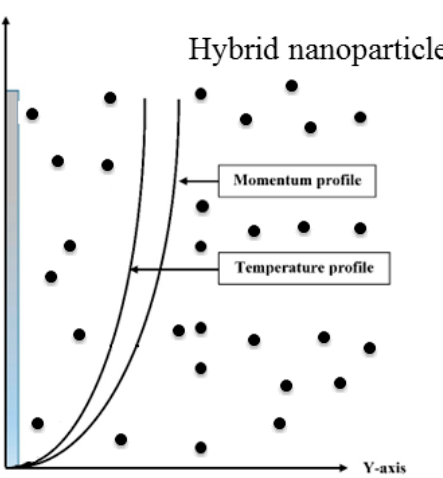
Figure 1. Flow Figure 1. Flow configuration.